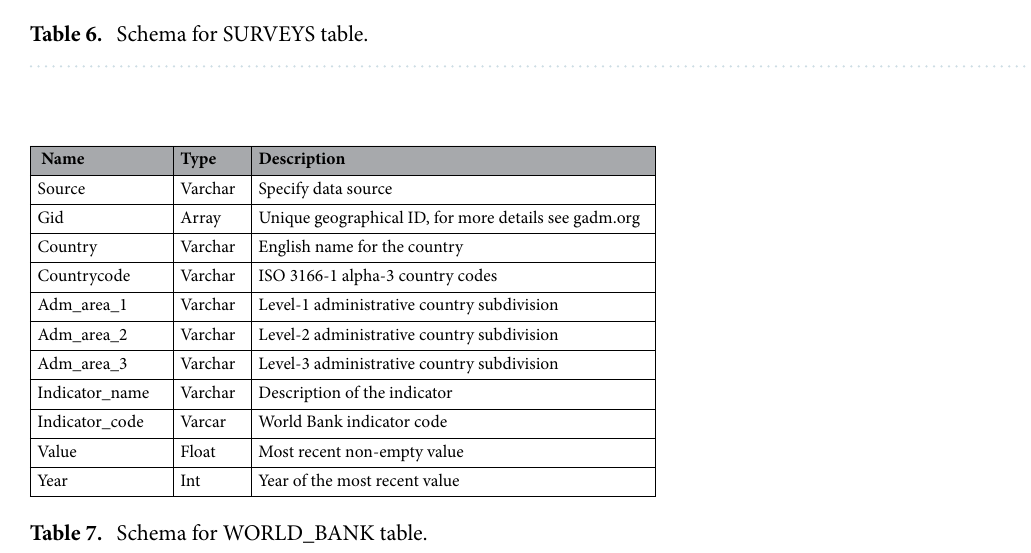
Table 7. Schema for WORLD_BANK